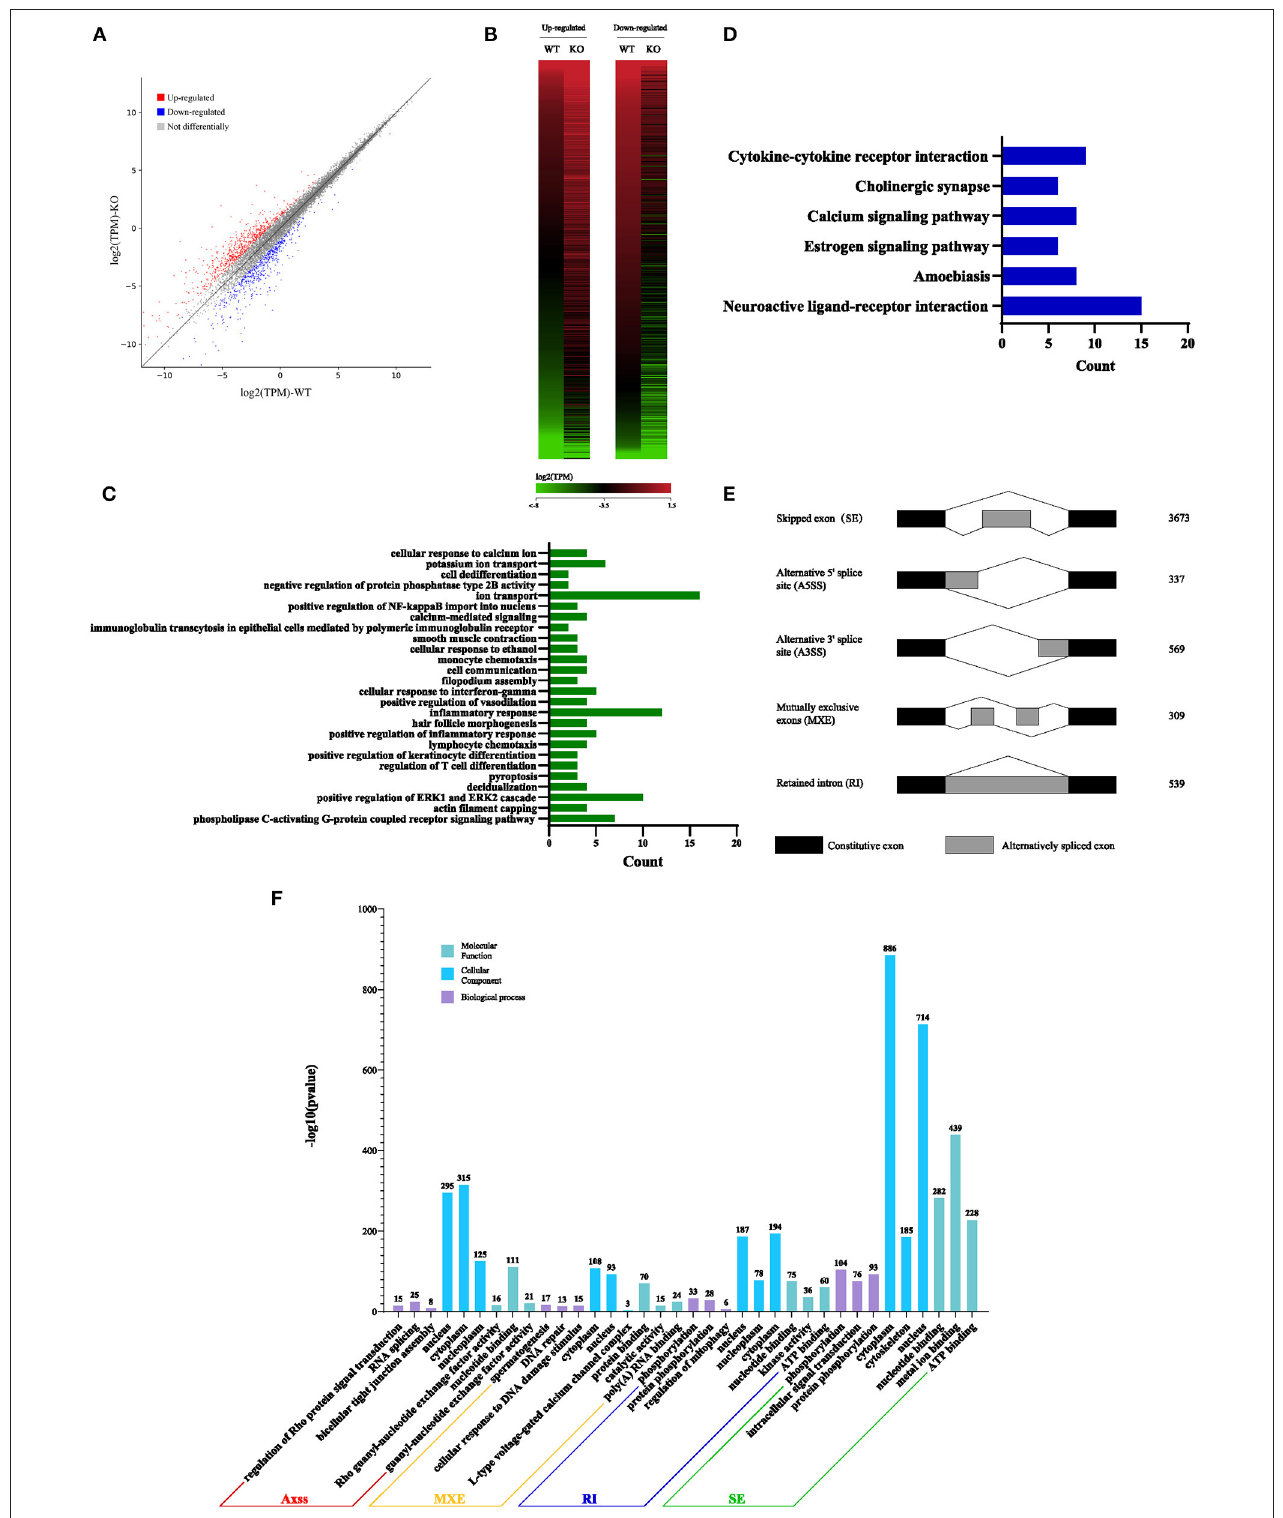
FIGURE 8 | Sugp2 is involved in RNA splicing during spermatogenesis. Volcano plot (A) and heat map (B) of differentially expressed transcripts in Sugp2 KO testis compared with WT control. Green dots represent significantly downregulated transcripts, red dots represent significantly upregulated transcripts (|log2FC| > 1), and gray dots represent unchanged transcripts. Gene Ontology (GO) (C) and Kyoto Encyclopedia of Genes and Genomes (D) functional analysis of differentially expressed genes. (E) Five significantly affected RNA splicing events in Sugp2 KO spermatogenic cells from adult mice. (F) The three most significantly ( P < 0.05) enriched GO terms in biological process, molecular function, and cellular component branches from each AS group are presented.